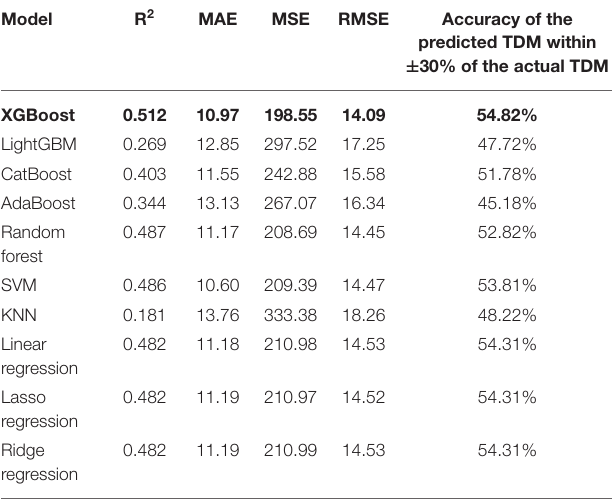
XGBoost, Extreme Gradient Boosting; SVM, support vector machine; KNN, k-Nearest Neighbor; MSE, Mean Square Error; RMSE, Root Mean Square Error; MAE, Mean Absolute Error. Bold values mean the best prediction performance among ten models.